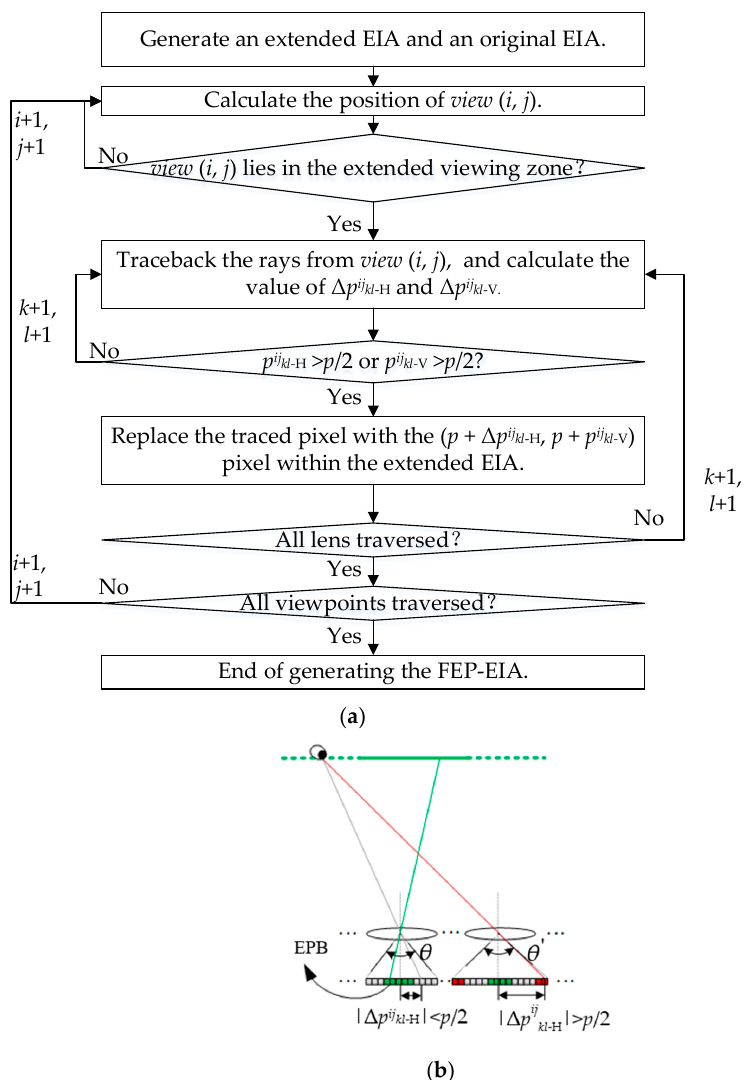
Figure 6. Generation of the FEP-EIA. ( a ) Flowchart of the algorithm; ( b ) Relationships among view ( i , j ), lens ( k , l ) and Δ p ijkl- H.